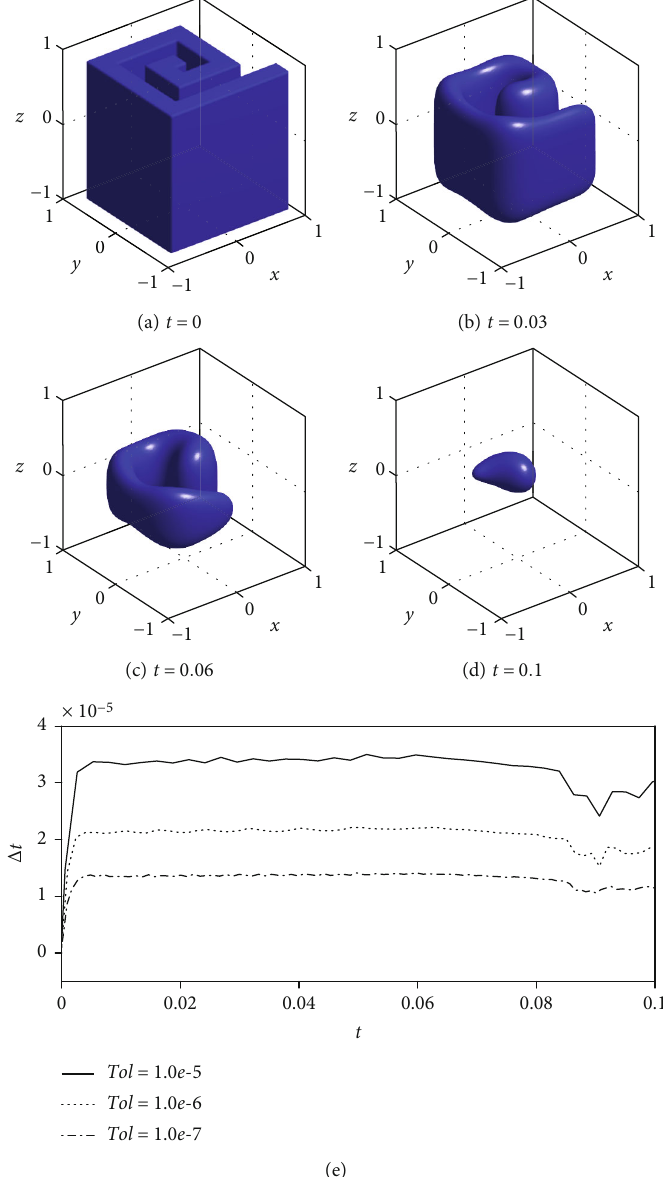
Figure 9: (a – d) Snapshots of the 3D spiral shape at time t = 0, 0 : 03, 0 : 06, and 0 : 1 , respectively. (e) Temporal evolution of the time step Δ t according to three di ff erent tol